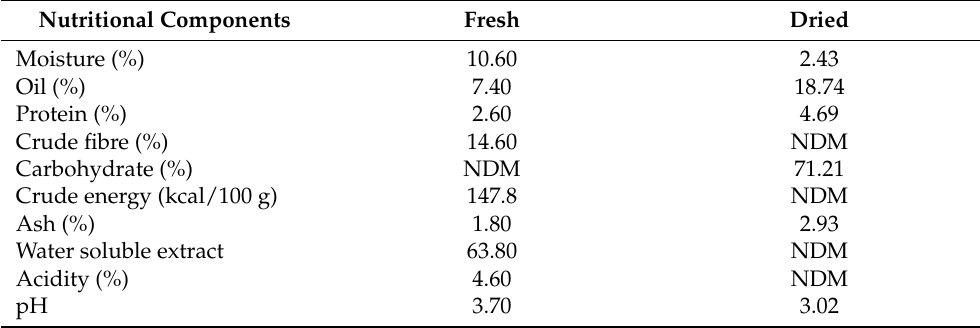
Table 1. Nutritional composition of the fresh and dried samples of sumac fruits.